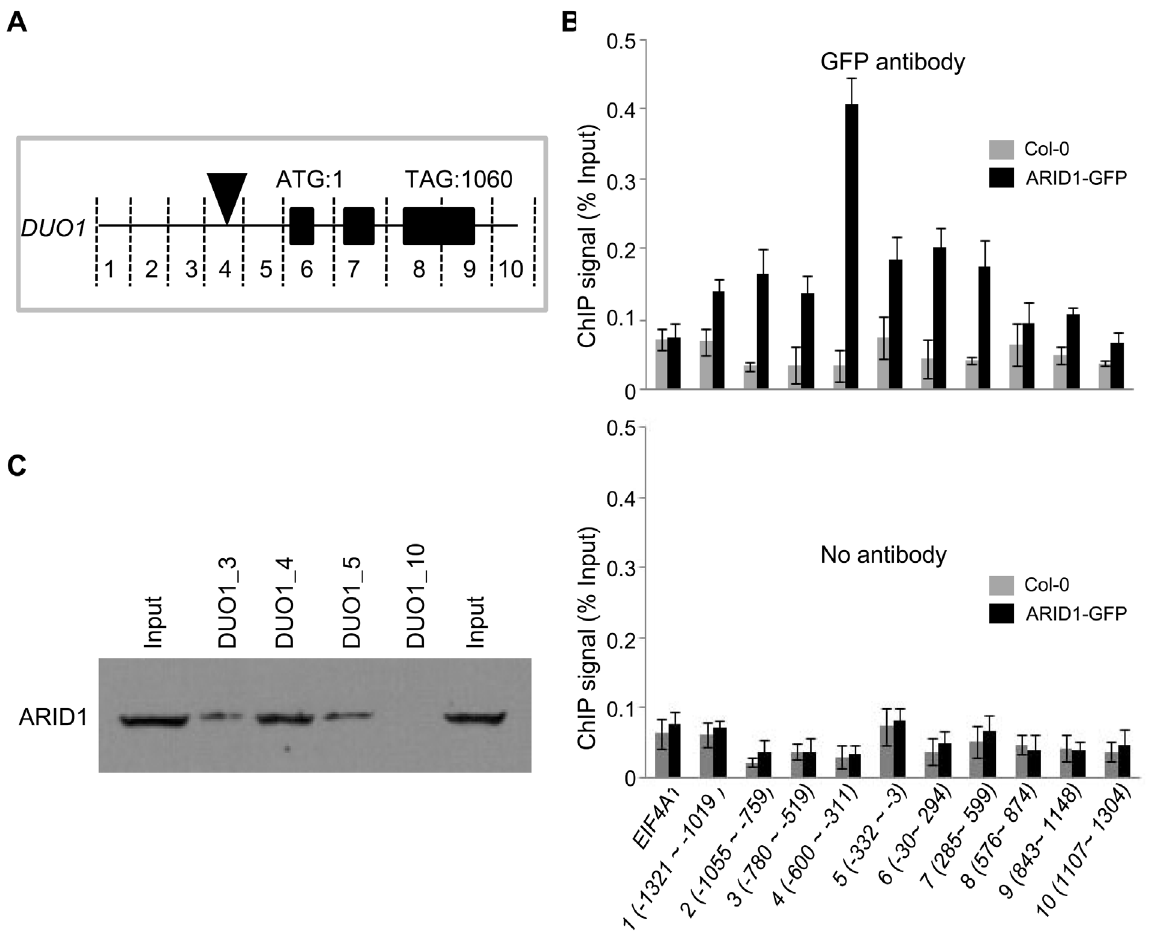
Figure 3. ARID1 binds to DUO1 . (A) Schematic of subfragments of DUO1 genomic DNA. The black rectangles represent exons. The black triangle indicates the region where ARID1 was most abundant. The position of the ATG was set to 1, and the fragments upstream or downstream were numbered; for example fragment ‘‘1’’ is 2 1321 to 2 1019 bp. (B) ChIP performed with wild type (gray bars) or ARID1-GFP (black bars) with GFP antibody (upper panel) and No antibody control (lower panel). EIF4A1 was used an internal negative control. The results were reproducible in two biological replicates. Error bars show SD calculated from three technical replicates. (C) DNA binding assay. Proteins were resolved by SDS-PAGE and then immunoblotted using anti-ARID1. The input lanes have 1/5 of the amount of ARID1 protein used in the DNA binding assay. The lanes numbered 3, 4, 5 and 10 (corresponding to regions mentioned in (A)) have 1/6 of the DNA-bound protein.